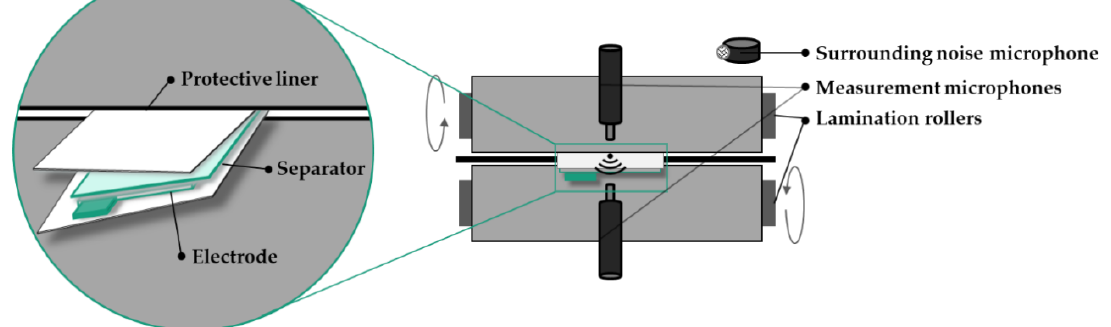
Figure 1. Experimental setup of the acoustic measurements during lamination. Initially, test recordings were made to evaluate the general noise emission during the lamination process with varying components (cathode, anode, separator and protective liner) and parameters (feed rate, roller temperature and pressure). The preliminary tests were used to identify acoustically measurable parameters and values to design the fol- lowing experiments. The evaluation showed that, in contrast to roller temperature and pressure, both component variation and feed rate could be identified acoustically. Since the feed rate is a control parameter, it was not considered further in the course of the study and was kept constant. The same applies for the pressure and the roller temperature. Sub- sequently to the preliminary tests, a test plan with quasi-randomized component compo- sition was created and executed. A total of 148 lamination tests was conducted within the same experimental setup at constant contact pressure of 1 kN, a feed rate of 16 mm/s and rollers without heating at ambient temperature of 20 °C. The component composition was varied between two different anodes and cathodes, each with and without separator, and one stand-alone separator (as shown in Table 1). The layered components surrounded by the protective liner were manually inserted into the contacting surface of the mechanical rollers. The same protective liner was used for each component composition (see ID in Table 1). Subsequently, the lamination rollers were moved together grasping the protrud- ing protective liner and leading to a draw-in and lamination of the material. Finally, the rollers were moved to their default position and the created ESL was removed. On aver- age, the duration of the acoustic signal was 4 s for the set material feed rate of the respec- tive compound, which corresponds to the time between the closing and opening of the lamination rollers including the lamination process itself.